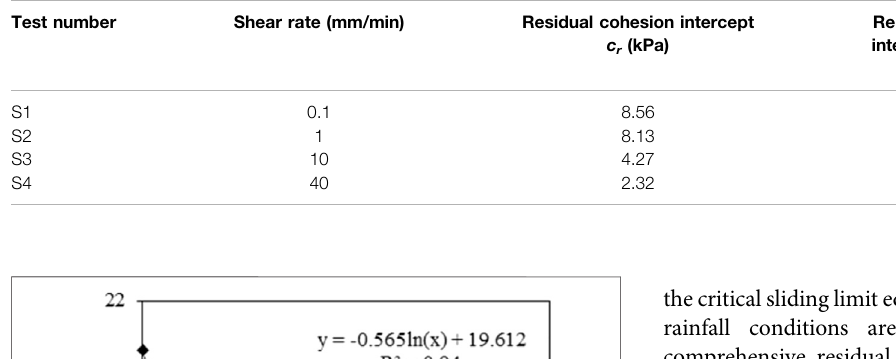
TABLE 3 | Residual strength index of clayey interlayer sliding zone soil under different shear rates.